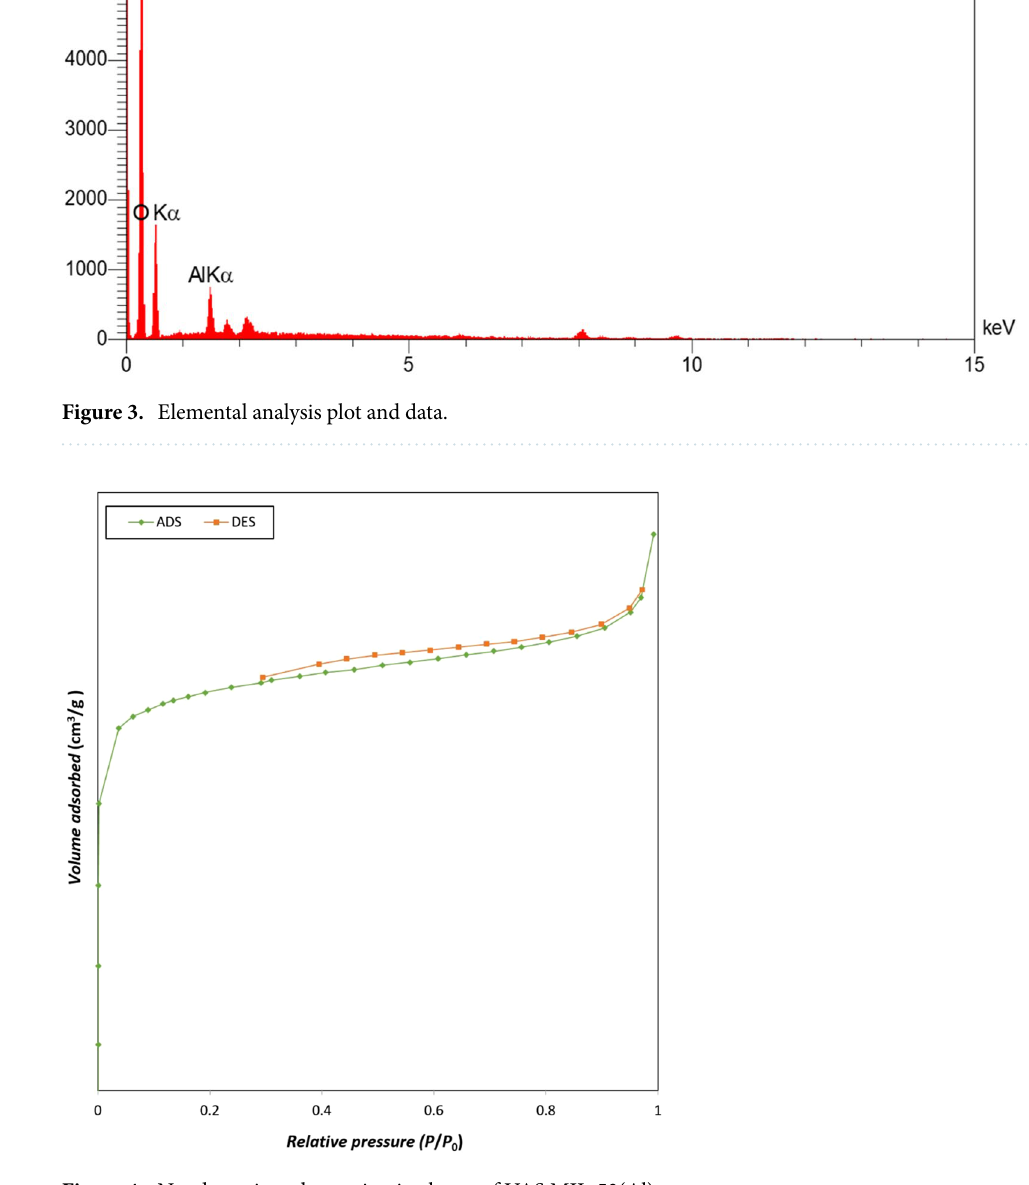
Figure 4. N 2 adsorption–desorption isotherm of UAS